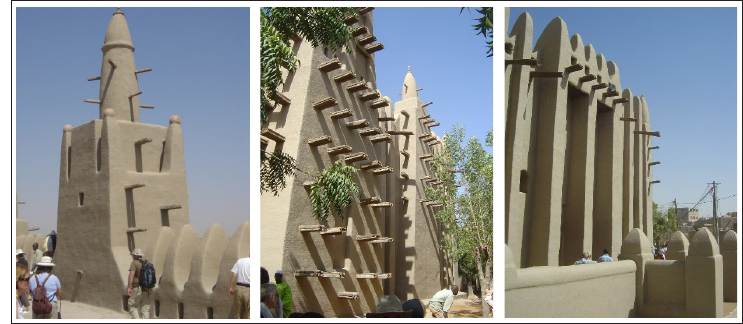
Figure 15: The restored rooftop with minarets, tower and facade of the Great Mosque of Mopti Source: Author,